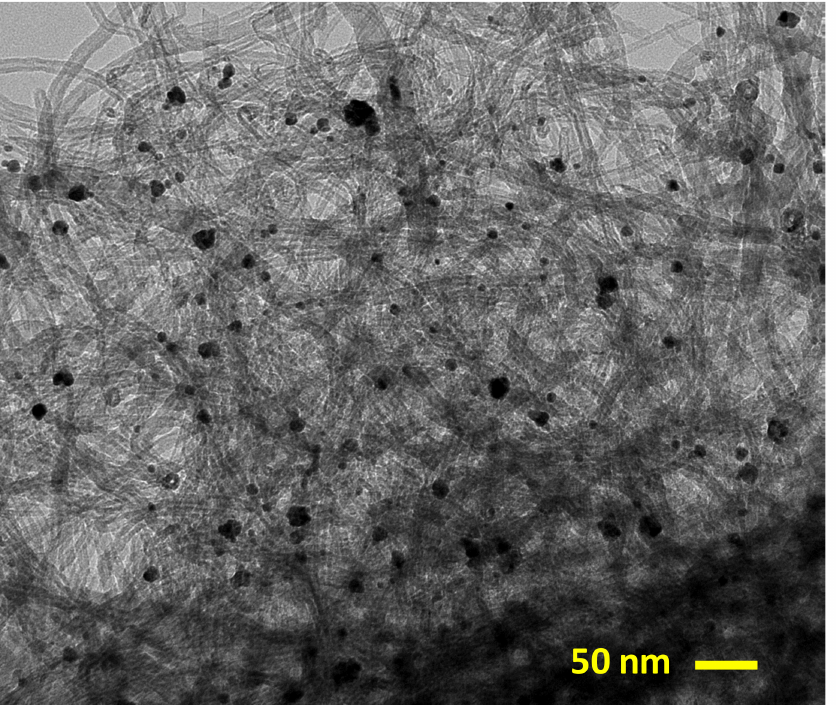
Figure 5. TEM image of the Au-Pd nanoparticles supported on functionalized carbon nanotubes